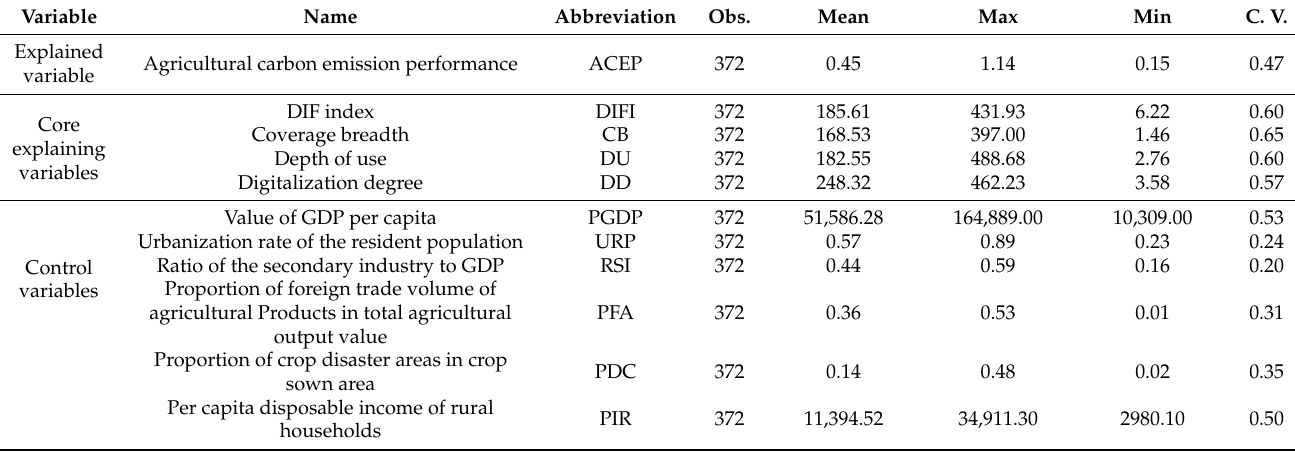
Table 3. Descriptive statistics of the